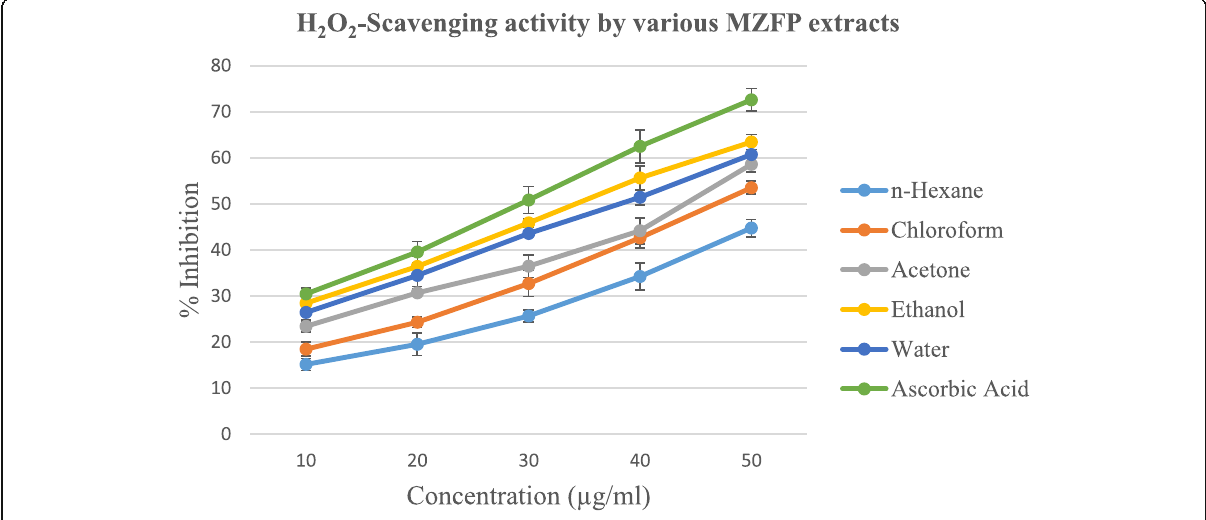
Fig. 3 H2O2-scavenging activity by various MZFP extracts. (Values are expressed as mean ± SEM of three